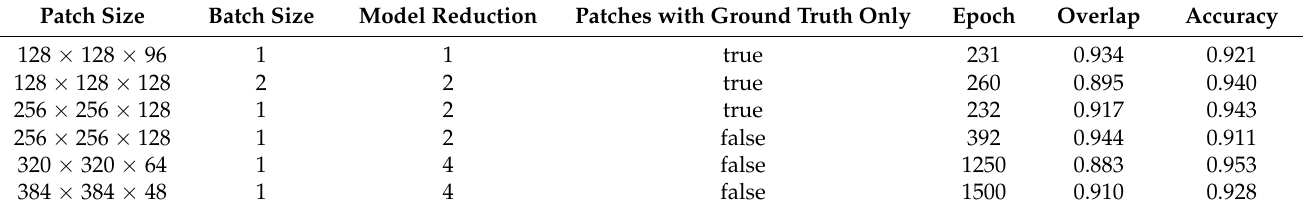
Table 2. The overlap and accuracy results for the selected hyperparameters.